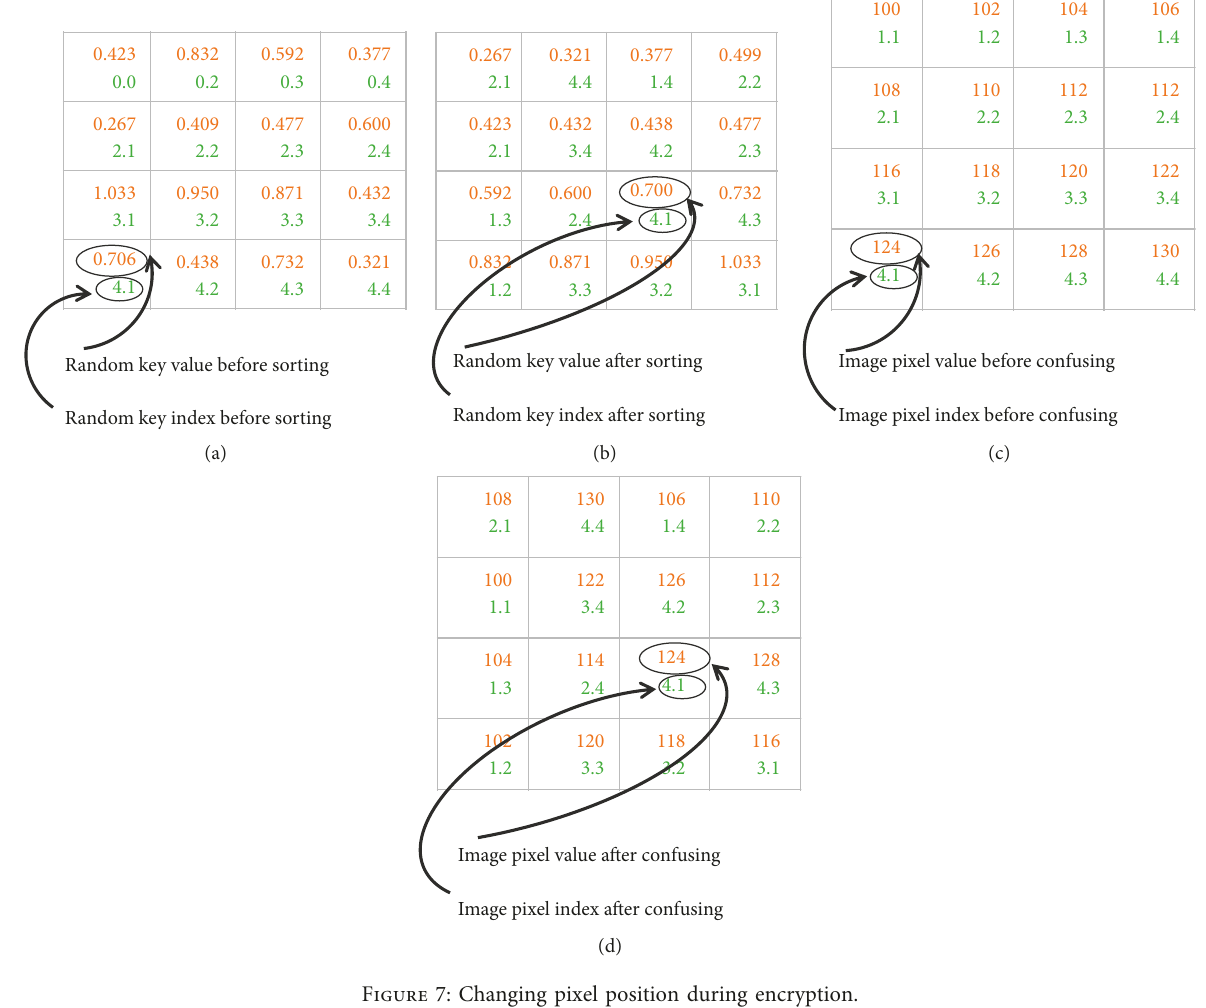
Figure 7: Changing pixel position during